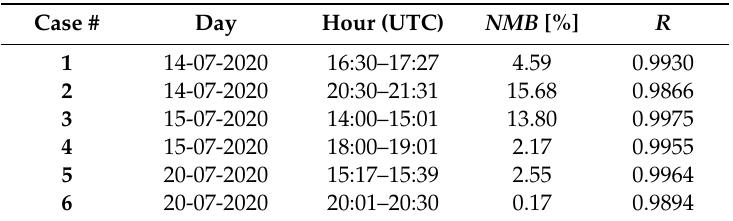
Table 1. Characteristics and statistical parameters of the 6